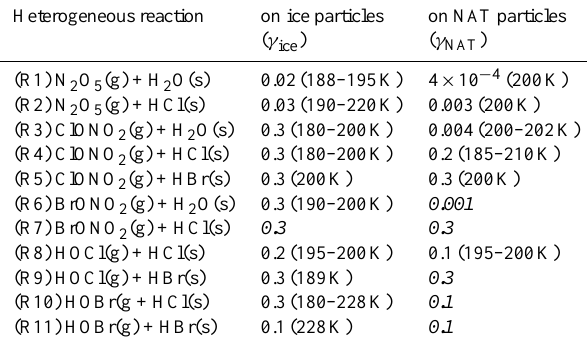
Table 3. Reaction probabilities γ for heterogeneous reactions on ice particles ( γ ice ) and on NAT particles ( γ NAT ) in the submodel PSC. Not in italics: γ from laboratory studies, valid for the temperature range in parentheses (Sander et al., 2003, 2006). In italics: γ as used in the original code of the “Mainz Stratospheric Box Model” (Carslaw et al.,